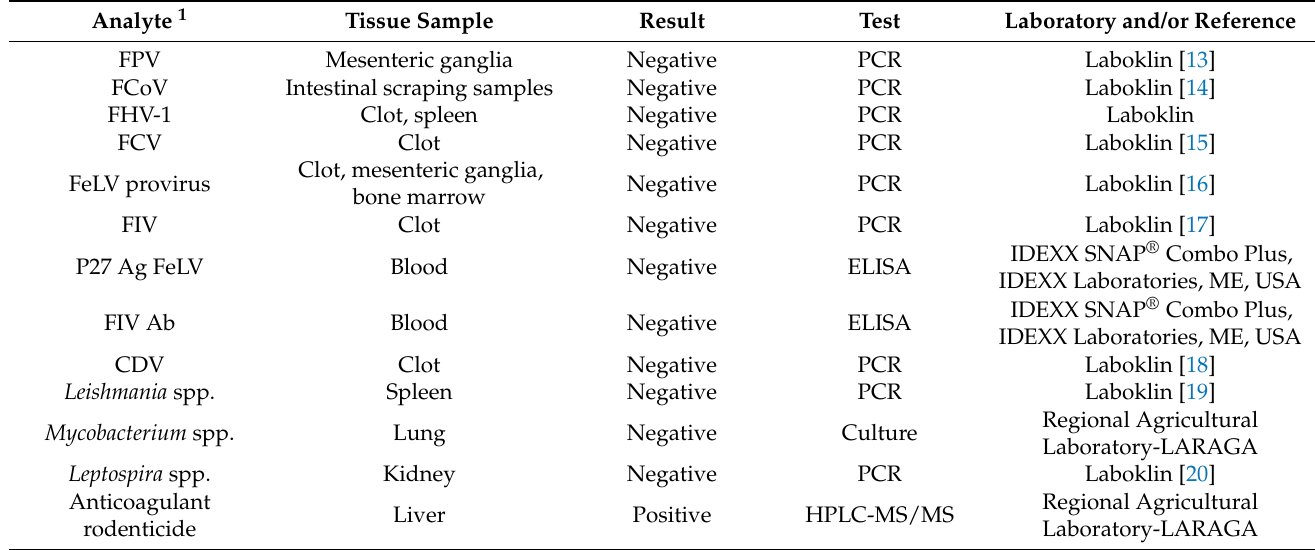
Table 1. Additional diagnostic tests performed in the female European wildcat ( Felis silvestris silvestris ) found dead in Ciudad Real province, Spain, in November 2020.